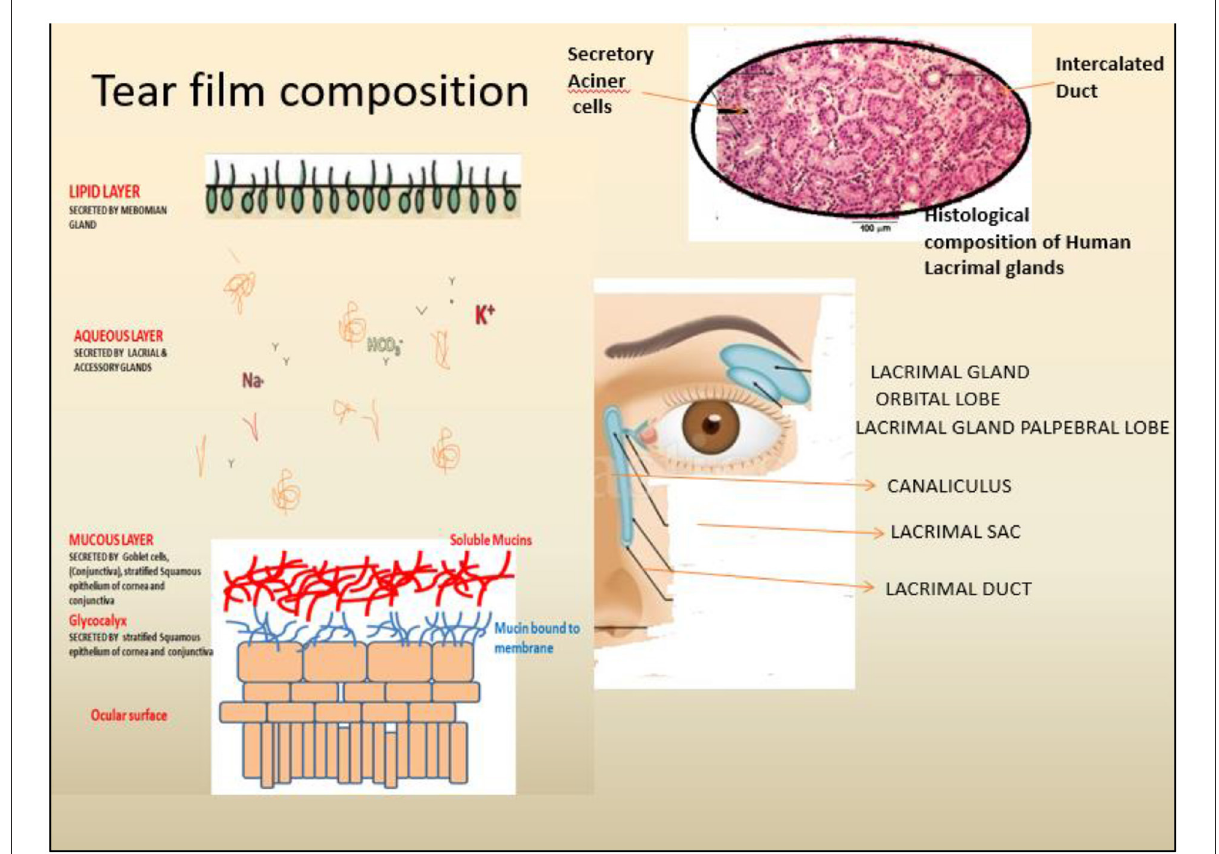
FIGURE1 Anatomical and physiological depiction of the human lacrimal gland and associated components. Tears are secreted by Lacrimal gland function units, including the lacrimal gland (LG) (Blue), the ocular surface (cornea, conjunctiva, and the meibomian gland) and the associated sensory and motor nerves. The tear film comprises three significant layers, i.e., Outer lipid, middle Aqueous and inner mucin-rich layers secreted by (Left) secreted by the meibomian gland, lacrimal gland and ocular surface goblet cells as